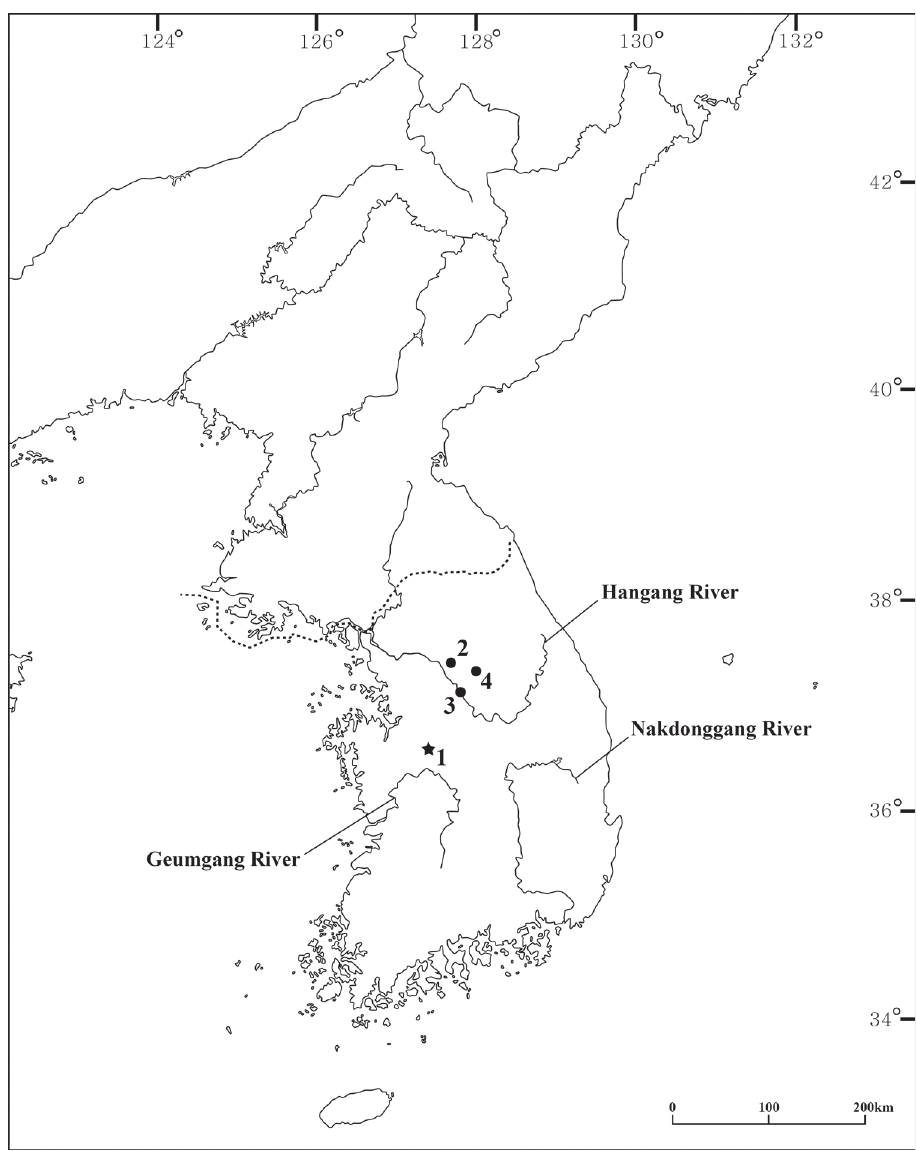
Figure 1. Distribution of species of the genus Hangangbathynella Park & Cho, 2013 1 H. mihoensis